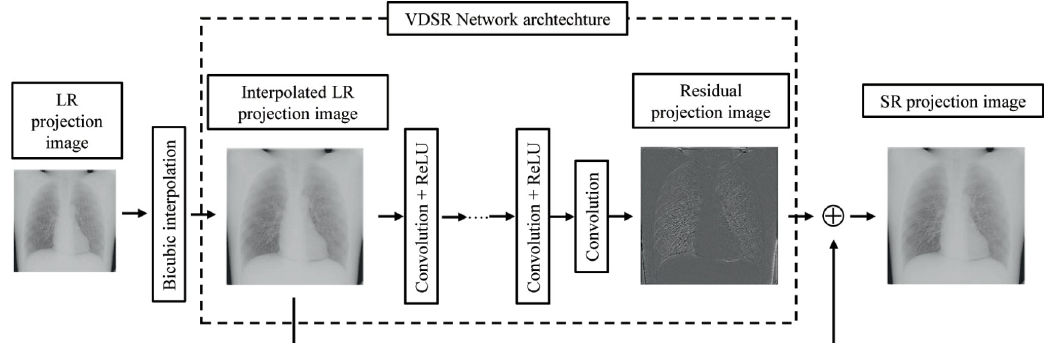
Fig 4. Network architectures. Convolutional neural network for super-resolution chest digital tomosynthesis.